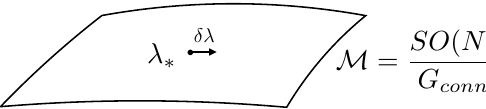
Figure 4: For fixed point perturbations by quartic scalar interactions correspond- ing to broken symmetry generators, linearized RG naively predicts that they are marginal. Instead such deformations correspond to total derivative operators of scal- ing dimension larger than d ; see the